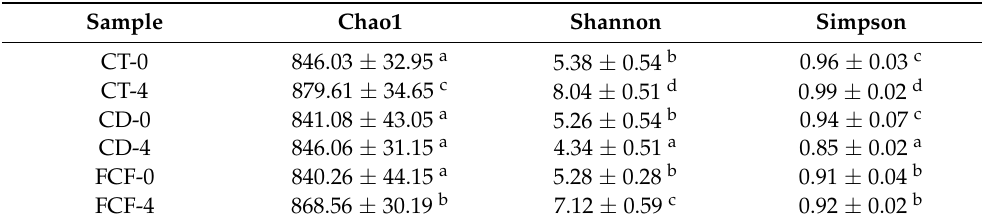
Table 2. Effects of FCF on the biodiversity of gut microbiota in the circadian rhythm disorder mice